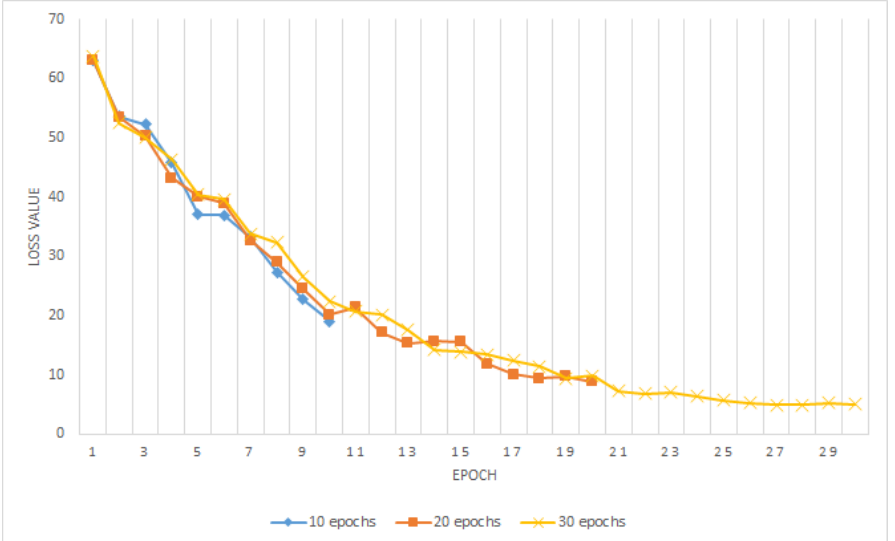
Figure 4. Sensitivity analysis results for number of